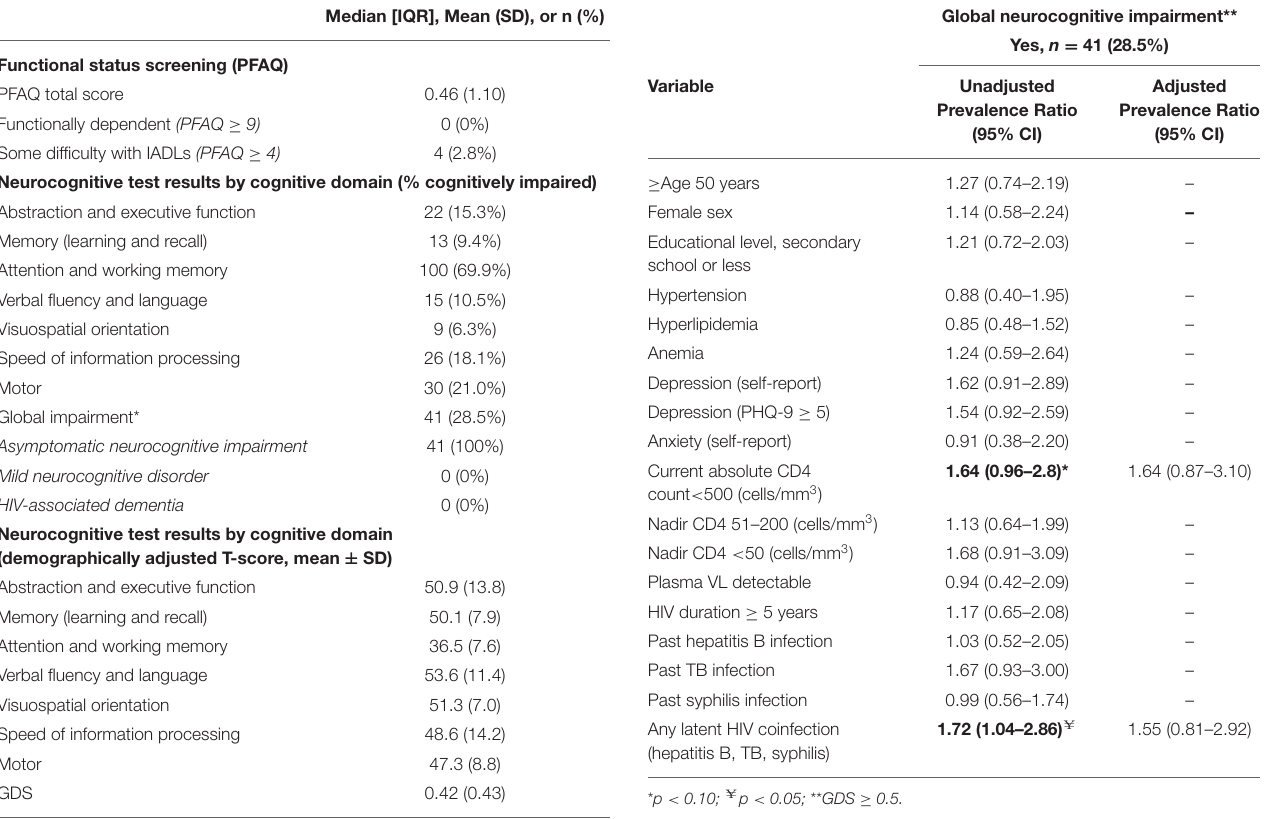
TABLE 4 | Regression models (unadjusted and adjusted) for risk factors for neurocognitive impairment ( N =